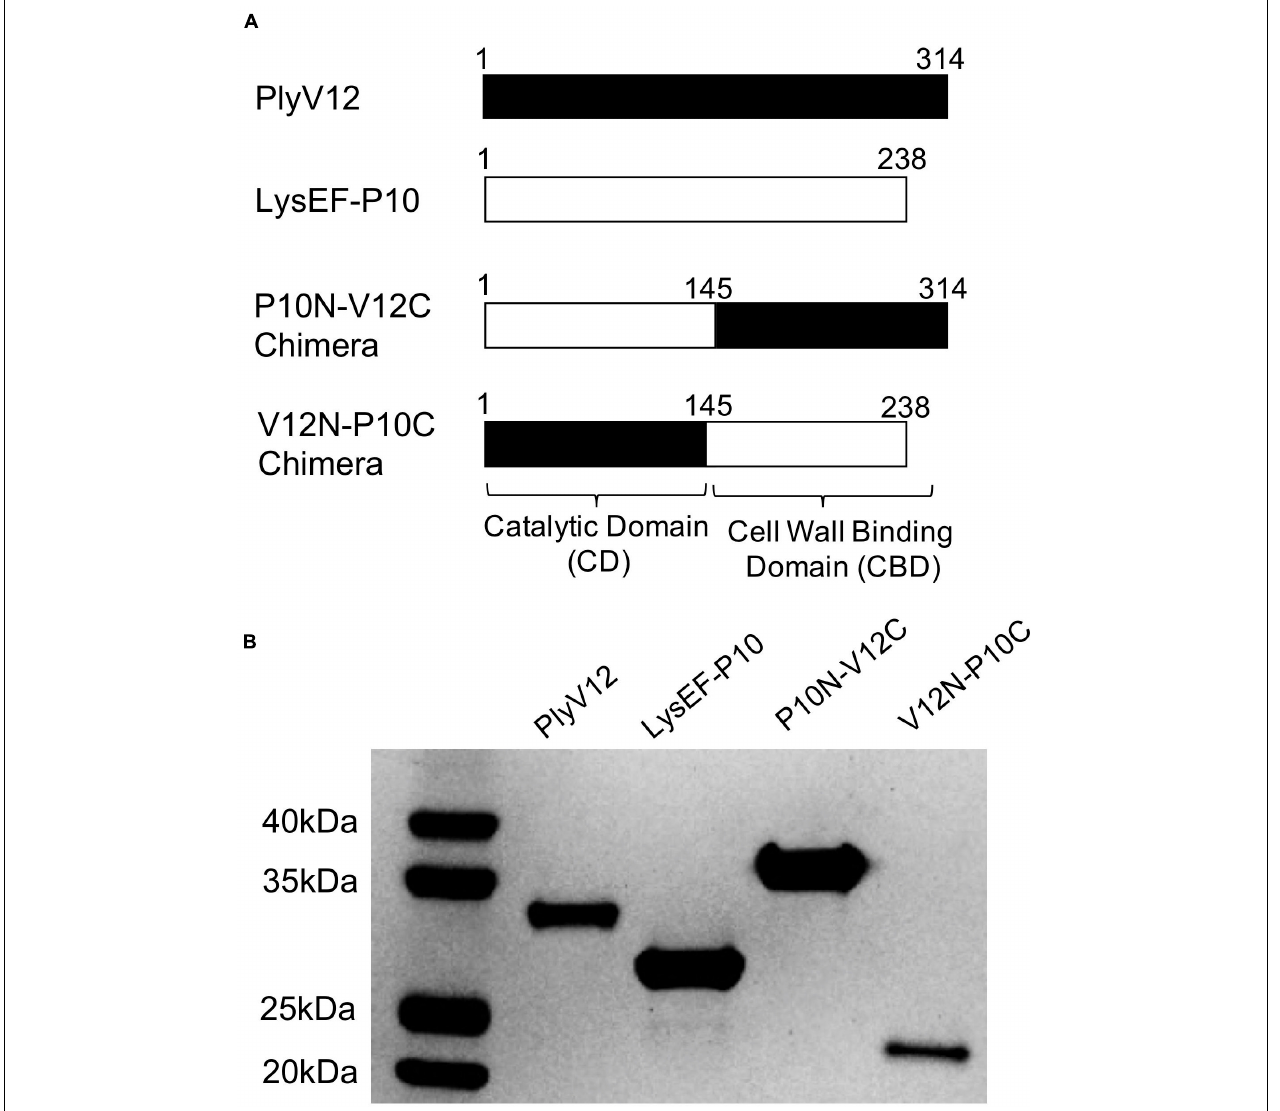
FIGURE 1 | Description of the parent and chimeric recombinant lysins. (A) Schematic diagram illustrating the domain swapping between the parent lysins to create the two chimeras. The N-terminal domain is the catalytic domain whereas the C-terminal domain is the cell wall binding domain. (B) The SDS-PAGE analysis showed the high purity of the produced lysins. PlyV12 (35.0 kDa), P10N-V12C (35.4 kDa), V12N-P10C (27.2 kDa) contain a C-terminal 6xHis tag, while LysEF-P10 (29.1 kDa) contains an N-terminal 6xHis-TEV for affinity chromatography purification.